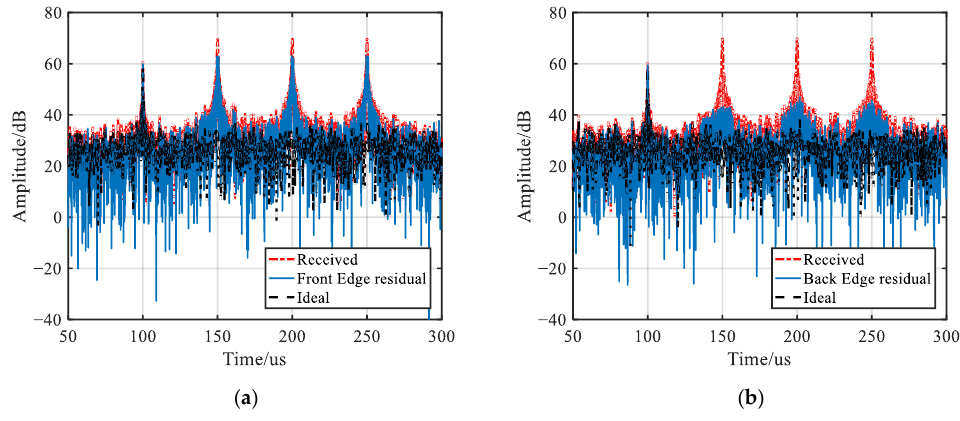
Figure 6. Influence of edge estimation error of: ( a ) Front edge; ( b ) Back edge. Different pulse edge detection methods have been studied regarding various types of radar signal. In this paper, the Difference of Box (DOB) filter [22] with STFRFT for pulse width detection is adopted since DOB is one of the most robust edge detection filters un- der Canny’s criteria and it can take the advantage of the temporal time-frequency analysis capability. Figure 7 shows the edge detection results of DOB with different filter lengths in different jamming cases. The signal to be detected is a four slice jamming. Note, that if the jamming pulses are separated in the time domain (jamming pulses forward discontin- uously), the edge detection filter can clearly identify the edges, as shown in Figure 7a; but once the pulses are close to the edge, as shown in Figure 7b, the filter output can only approximately indicate the existence of the edges.